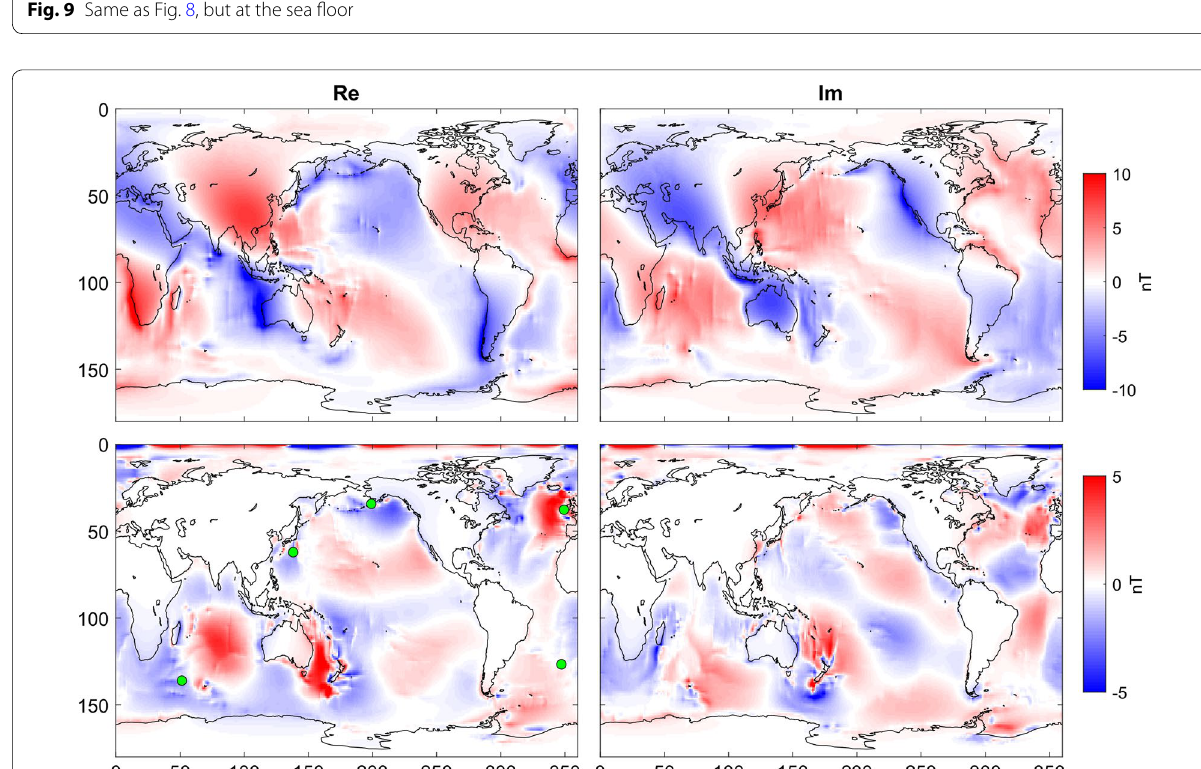
Fig. 10 Modeled Z component at a period of 12 h at the surface level. Top and bottom are the Sq and tidal fields, respectively. Left and right are the real and imaginary parts, respectively. Note the different scales for top and bottom plots, as well as with respect to the X , Y component plots. Because of the continuity of the Z component across the ocean column, Z at the sea floor is not